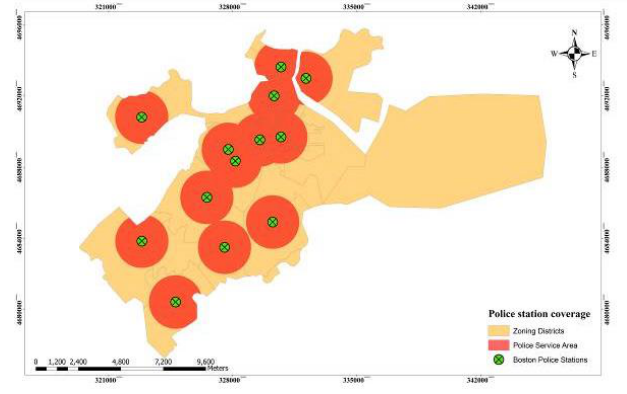
Figure 3. Police station